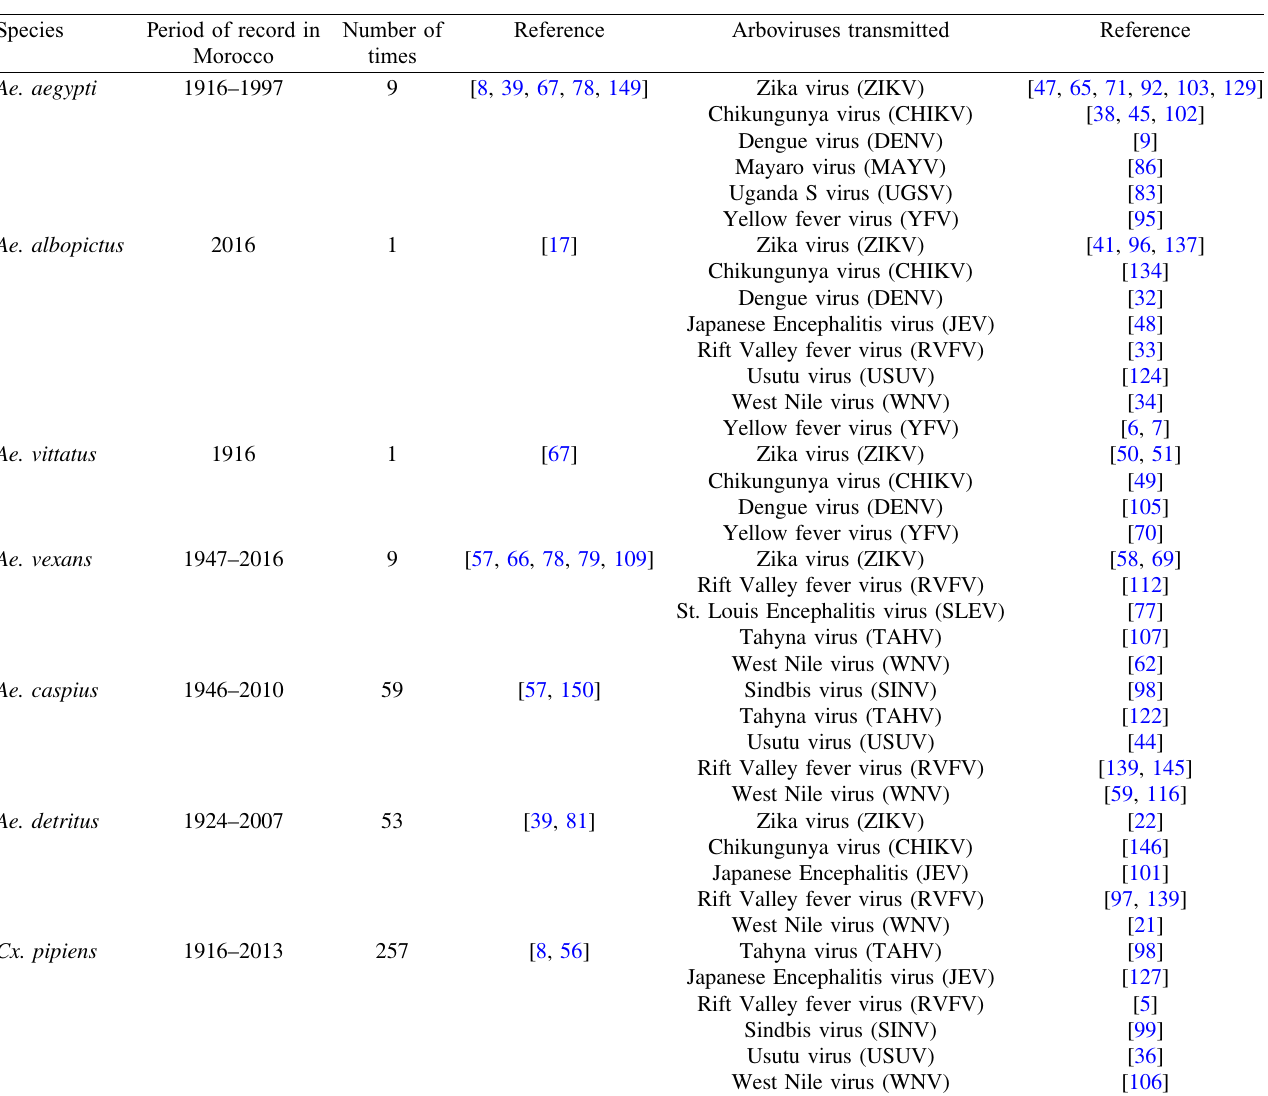
Table 1. Overview of the medical importance of certain mosquitos tracked in